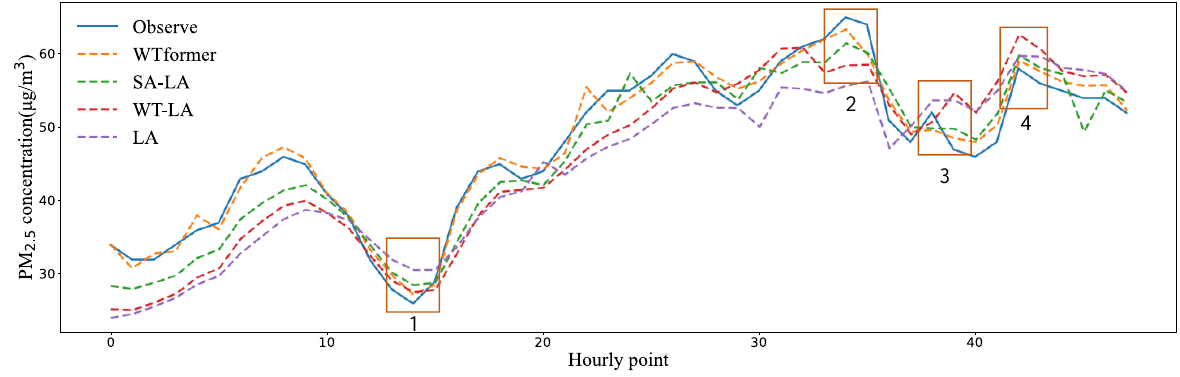
Figure 11. The predictions values of WTformer, SA-LA, WT-LA and LA.